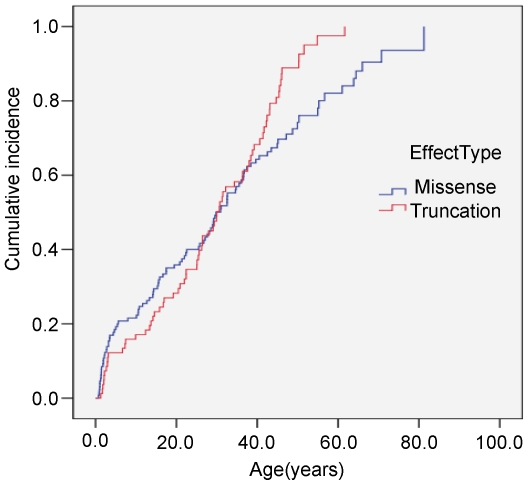
Kaplan-Meier estimated cumulative incidence for any cancer in carriers of a p53 germline mutation by mutation type.Among these 213 carriers(one missing type of mutation), 130 carried a missense mutation and 82 a truncation mutation (deletion 1, nonsense 50, frame-shift 16, splice 15). Log-rank test P = 0.0900.